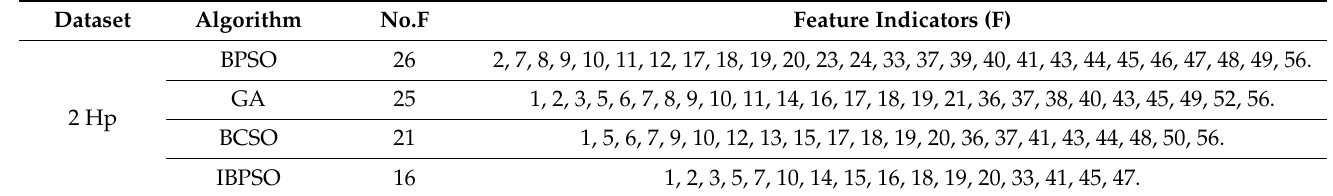
Table 10. Details of obtained optimal feature subset.